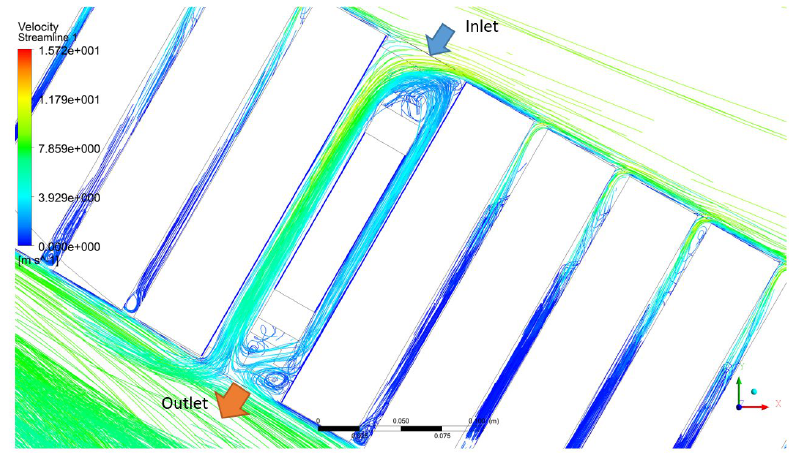
Figure 21. Streamlines of gap air flow near engine casing.